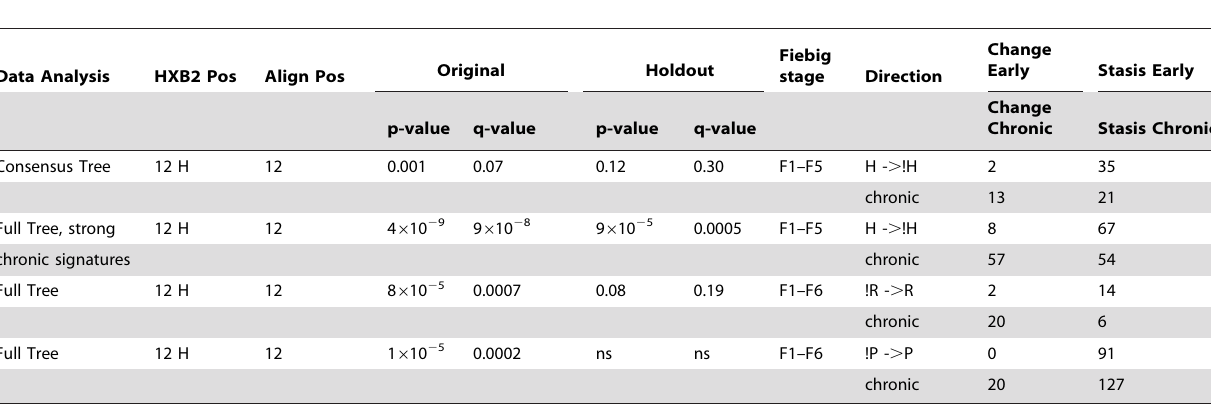
Table 2. Summary statistics for the only single-site signature found in Env based on within-subject consensus sequence analysis, His at position